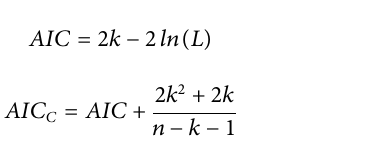
Frontiers in Built Environment |